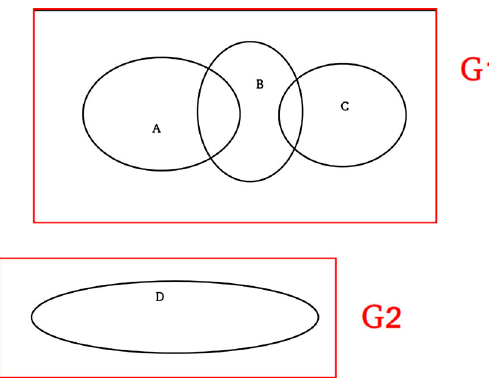
Fig. 3 Example for a disjoint group selection for one analysis. The analysis has four SRs (A,B,C,D). Because SR A overlaps with SR B and SR B overlaps with SR C, we grouped SR A,B and C into one disjoint group G1. Because SR D does not overlap with any of the other SR of the analysis, the disjoint group G2 only contains the SR D